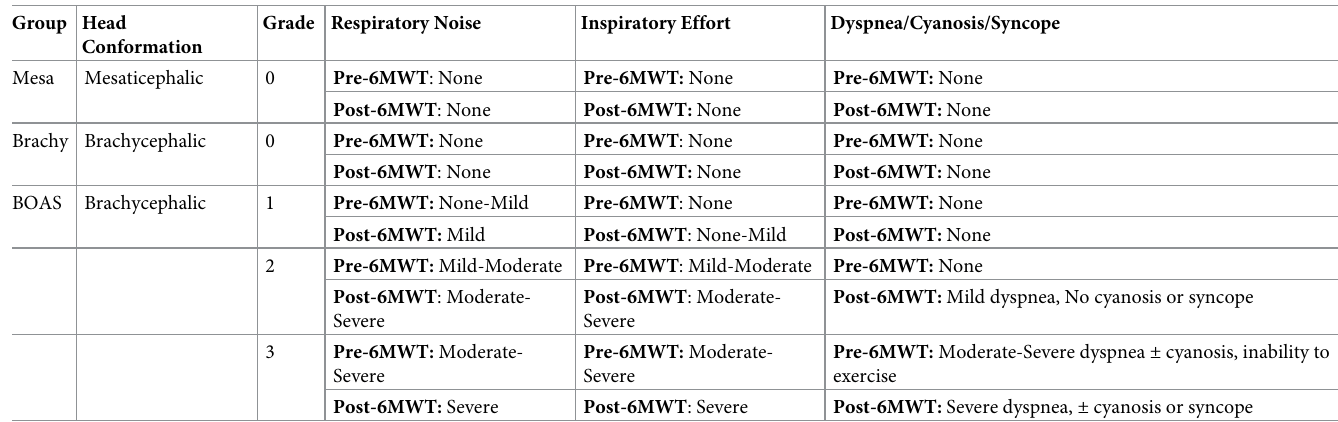
Table 1. BOAS grading